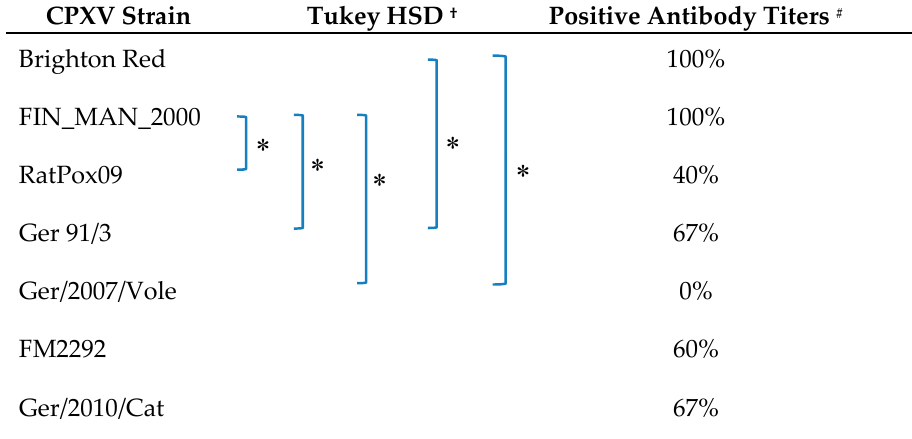
Table 4. Viral DNA detection in different organs at 5